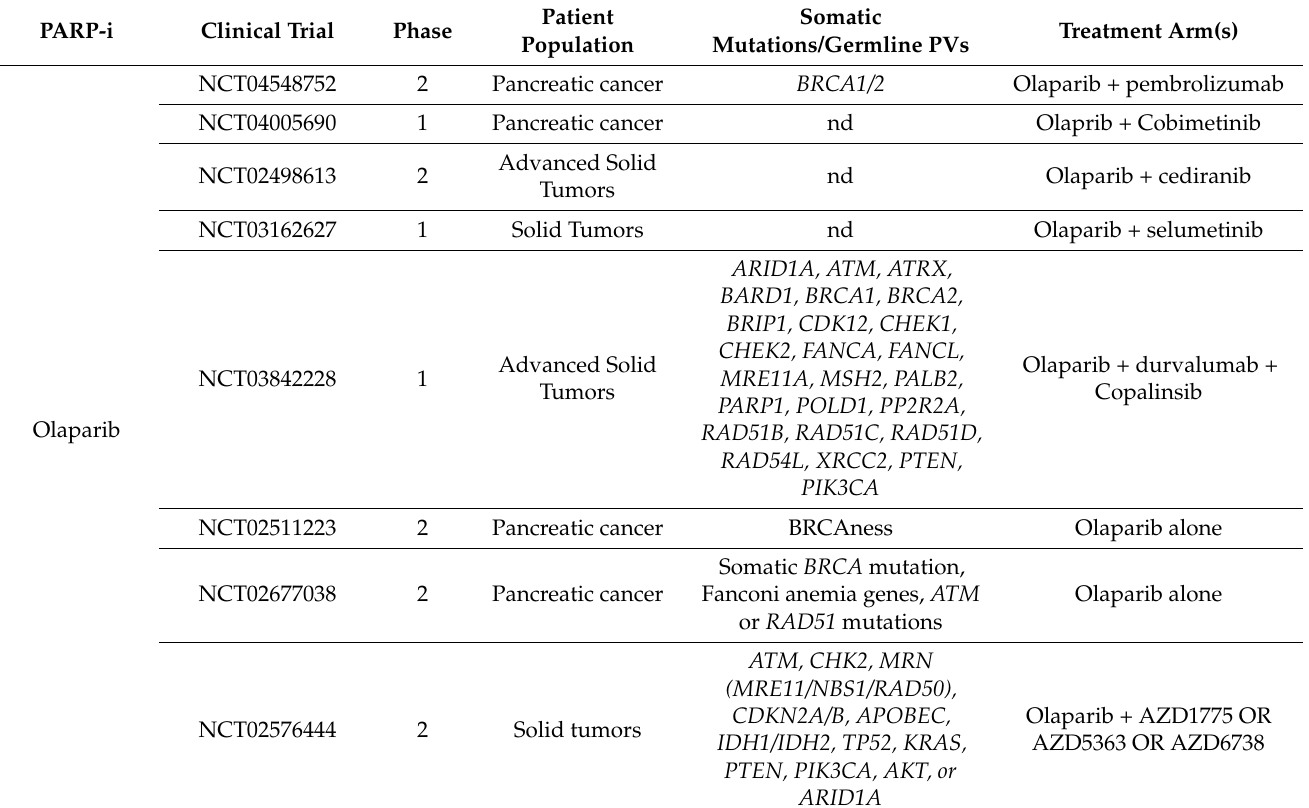
Table 2. Ongoing clinical trials on PARP-i in pancreatic